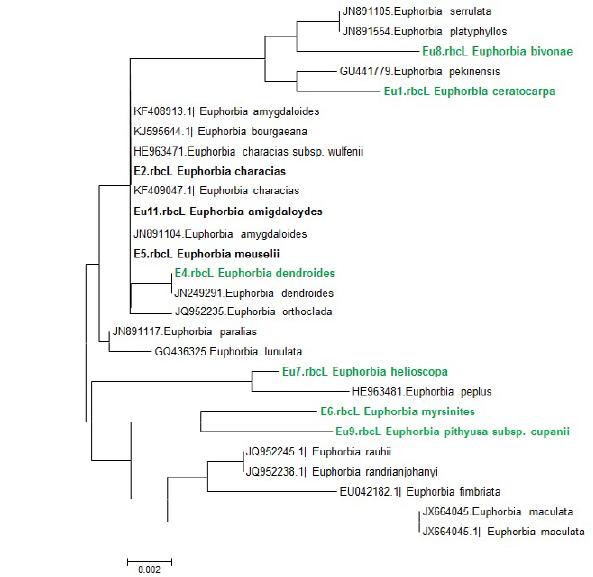
Fig. 4. Phylogenetic tree of Euphorbiaceae family with Neighbor Joining for rbc L